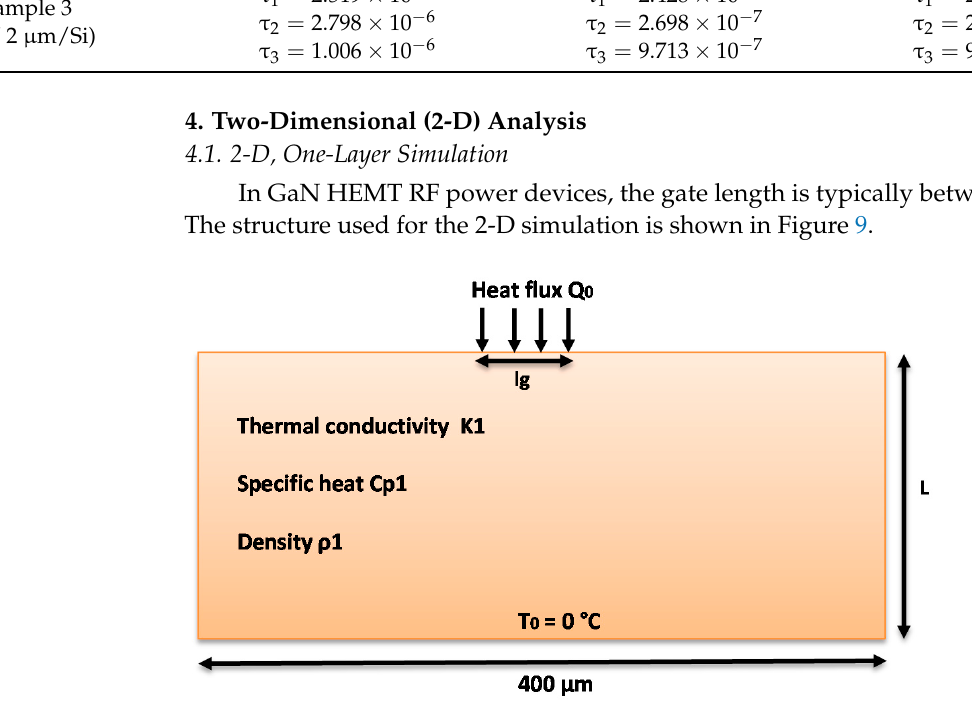
Figure 9. 2-D single-layer structure.